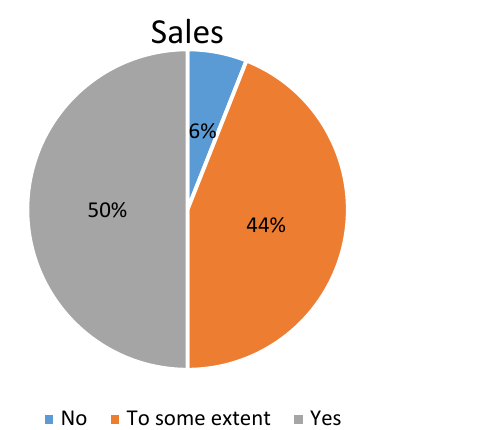
Figure 1. Frequency Distribution of Subjects Based on Satisfaction With Advertising.